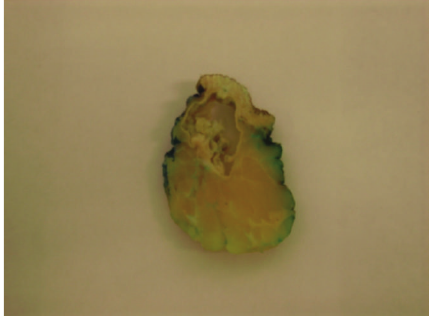
Figure 1: Photography of recurrent tumor in the right breast beneath the previous site of resection. Note the nodule under the scar deforming the overlying skin.